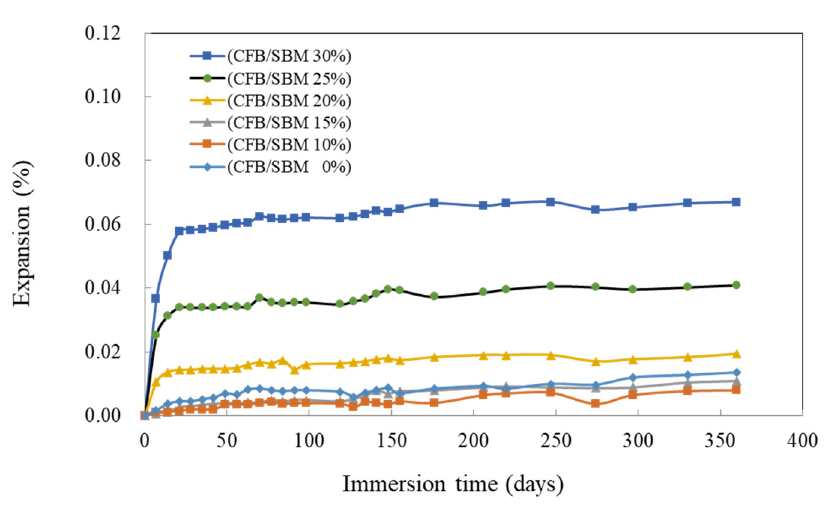
Figure 8. Expansion of mortars with different CFB fly ash/SBM ratio under internal sulfate attack.